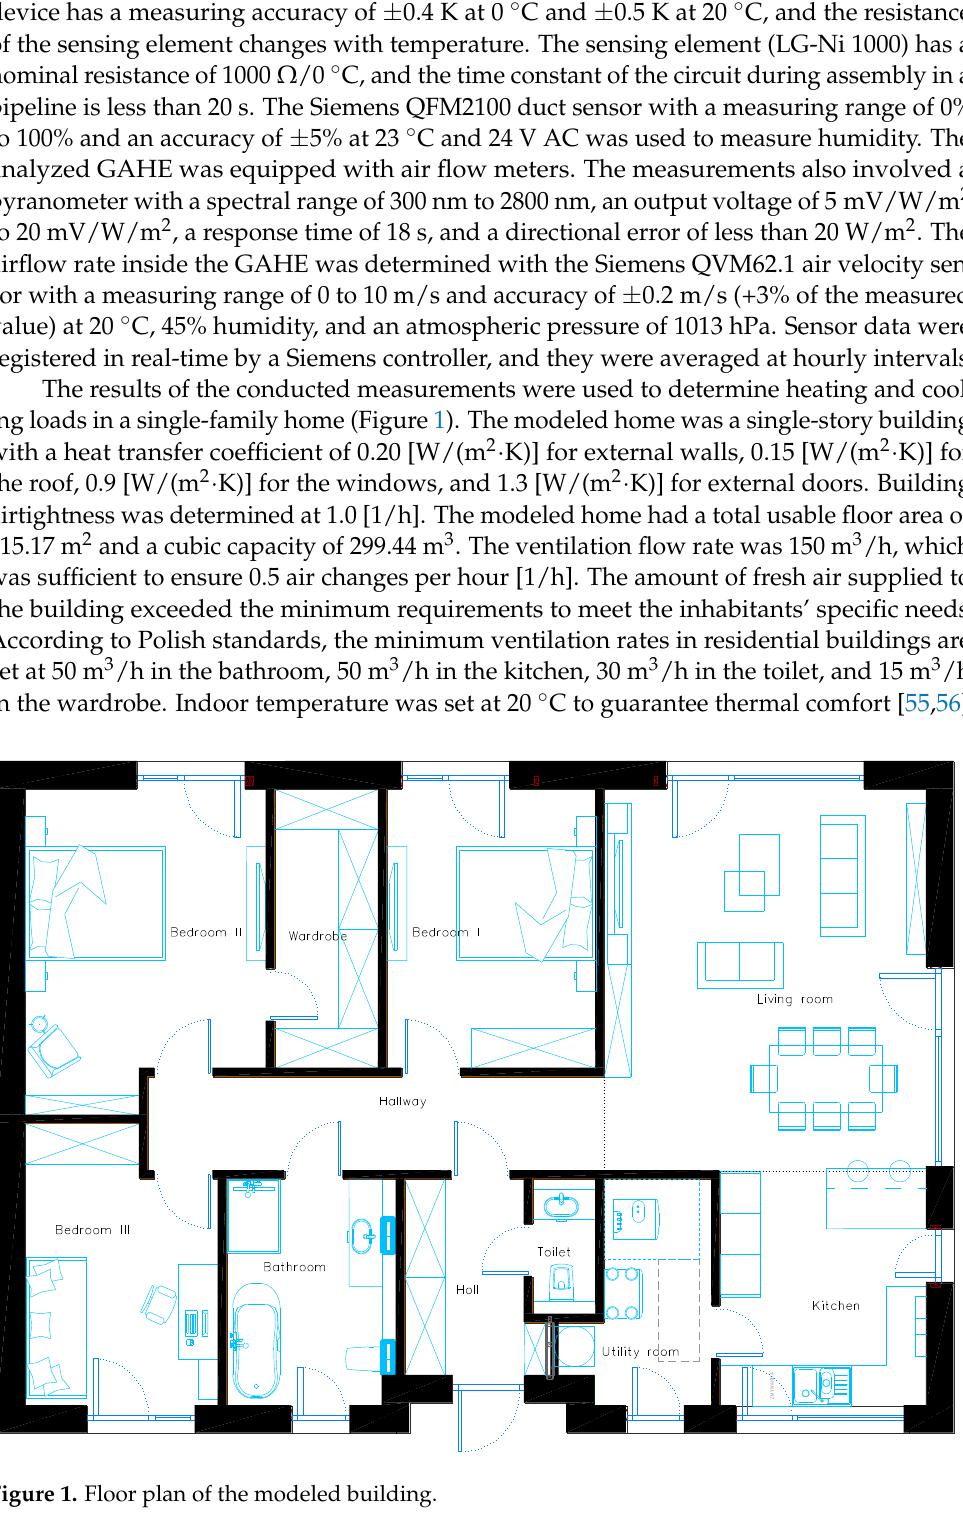
Figure 1. Floor plan of the modeled building.